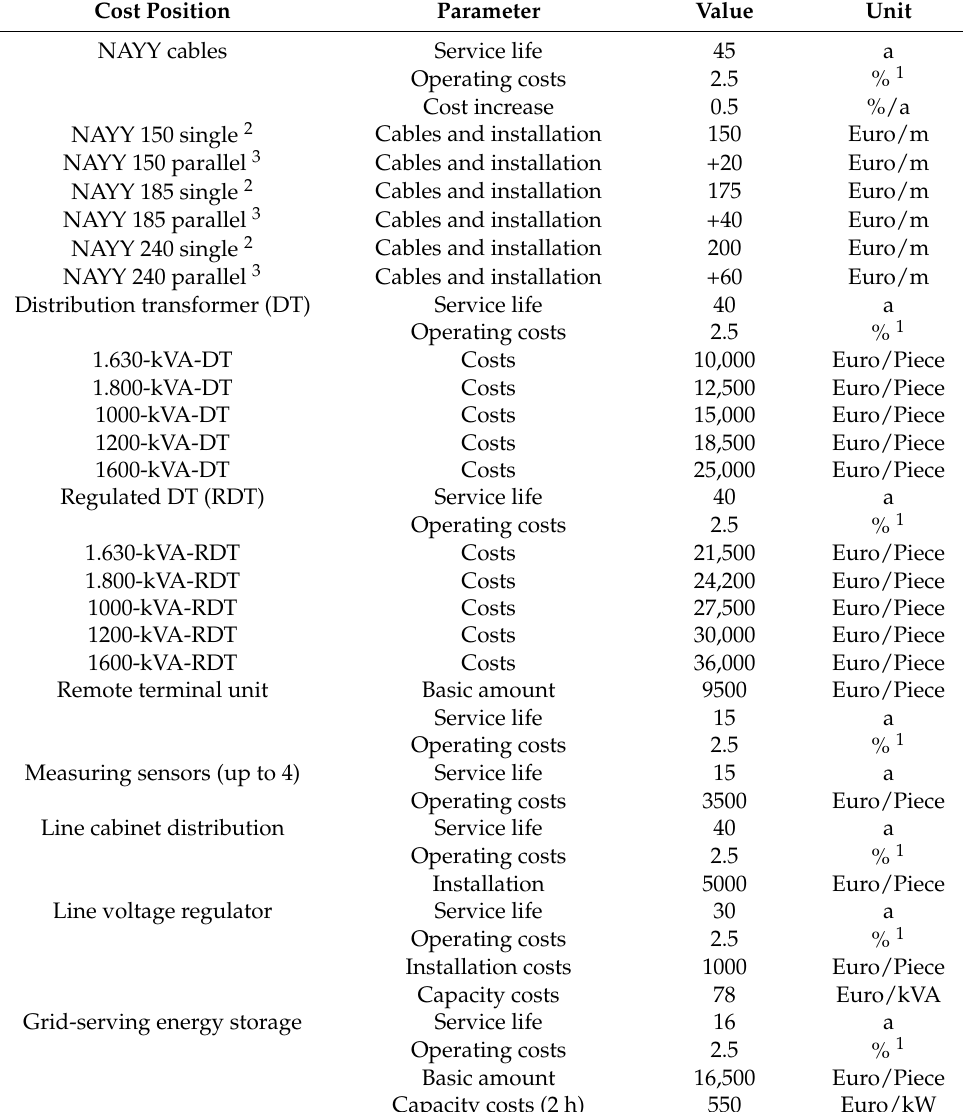
Table A1. Cost assumptions for low-voltage equipment based on